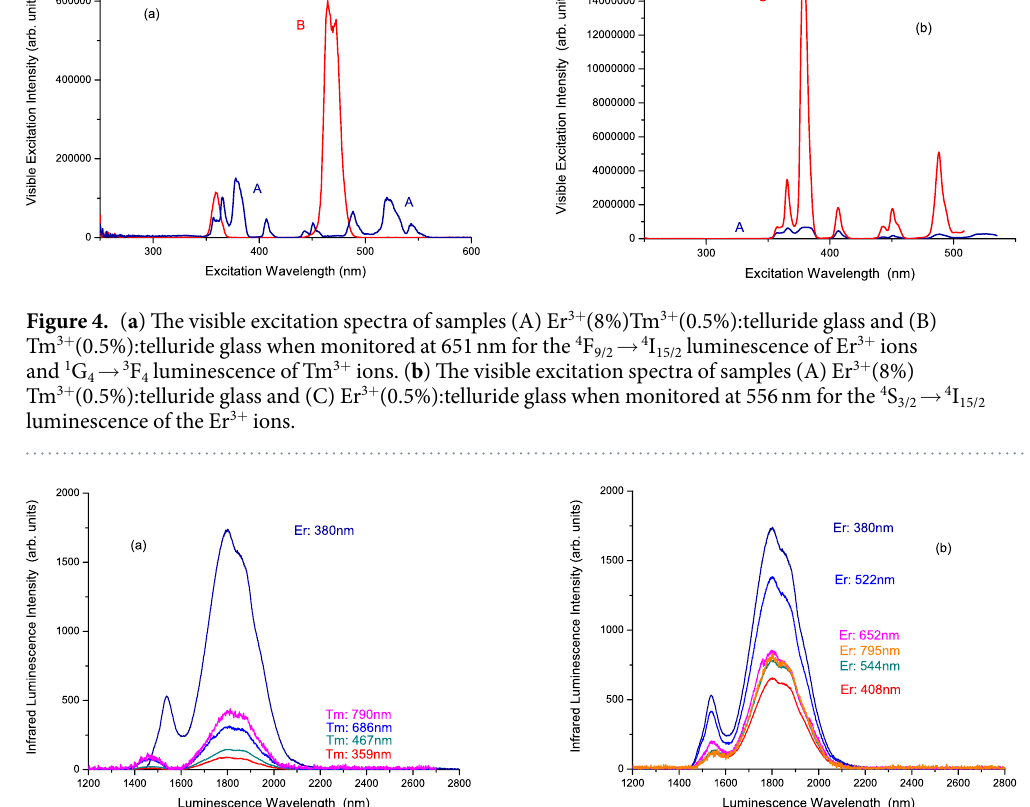
4 I 4 I 4 I 4 I 3 + ions, respectively 16, 18 . This → 4 F → 4 F → 2 H → 4 S 15/2 5/2 , 15/2 7/2 , 15/2 11/2 , and 15/2 3/2 transitions of the Er implies that the excitation energy for the 651 nm luminescence in sample (A) Er 3 + (8%)Tm 3 + (0.5%):telluride glass came from the Er 3 + ions already. We also selected the 556 nm visible luminescence wavelength of Er 3 + ions in the telluride glass to measure the visible excitation spectra, from 250 nm to 535 nm, in sample (A) Er 3 + (8%) Tm 3 + (0.5%):telluride glass and sample (C) Er 3 + (0.5%):telluride glass. These results are shown in Fig. 4(b). The spectrum of Fig. 4(b) is the characteristic excitation spectrum of Er 3 + ions 16, 18 . Luminescence spectra.